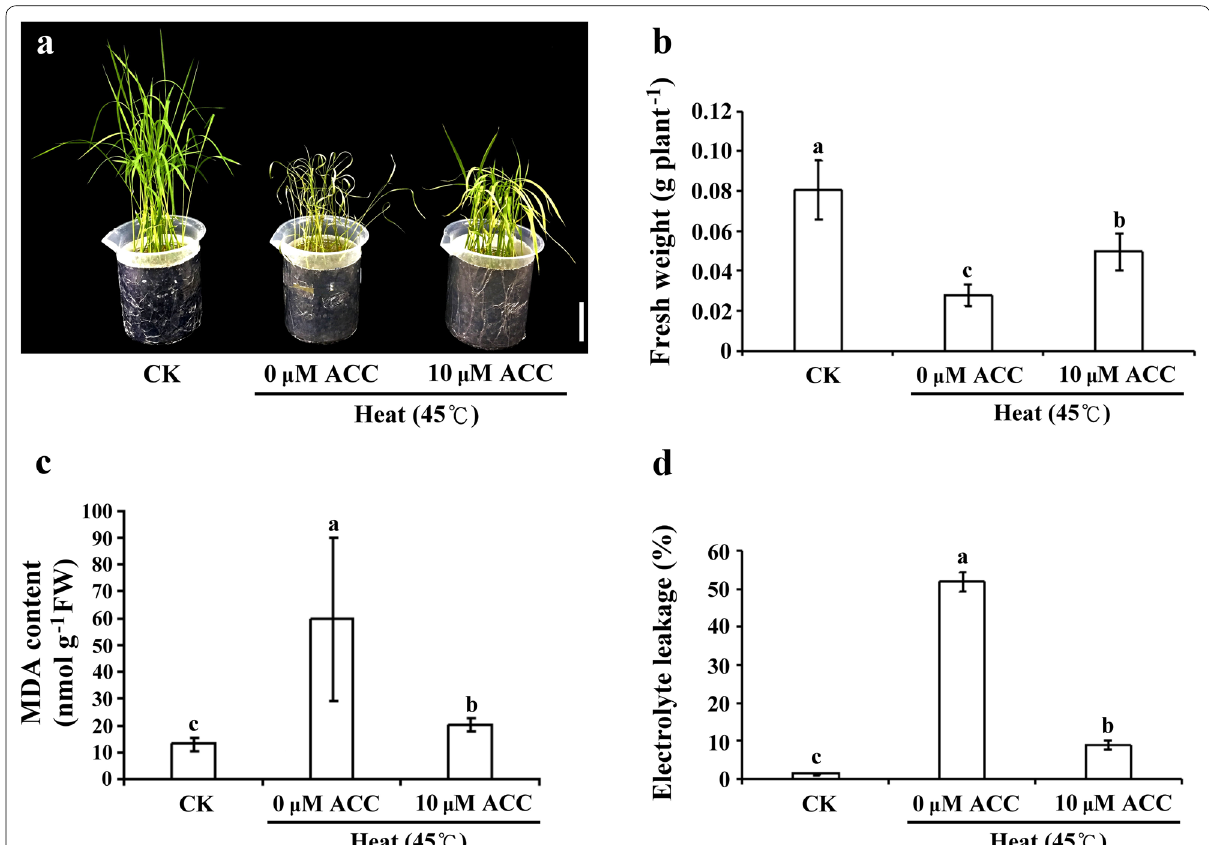
Fig. 1 Effects of heat stress with ACC treatment on phenotype and physiological properties of rice seedlings. a Phenotypes of 12‑day‑old rice seedlings exposed to heat treatment at 45 °C with or without 10 μM ACC for 4 days. The same results were observed for three independent experiments. Bar 5 cm. Fresh weight ( b ), malondialdehyde (MDA) content ( c ), and electrolyte leakage ( d ) in rice seedlings exposed to heat = treatment at 45 °C with or without 10 μM ACC for 4 days. Control check (CK). Values are presented as mean seedlings of each treatment obtained from three biologically independent experiments. Different letters indicate significant difference between the treatments assessed using the LSD post hoc test ( P <